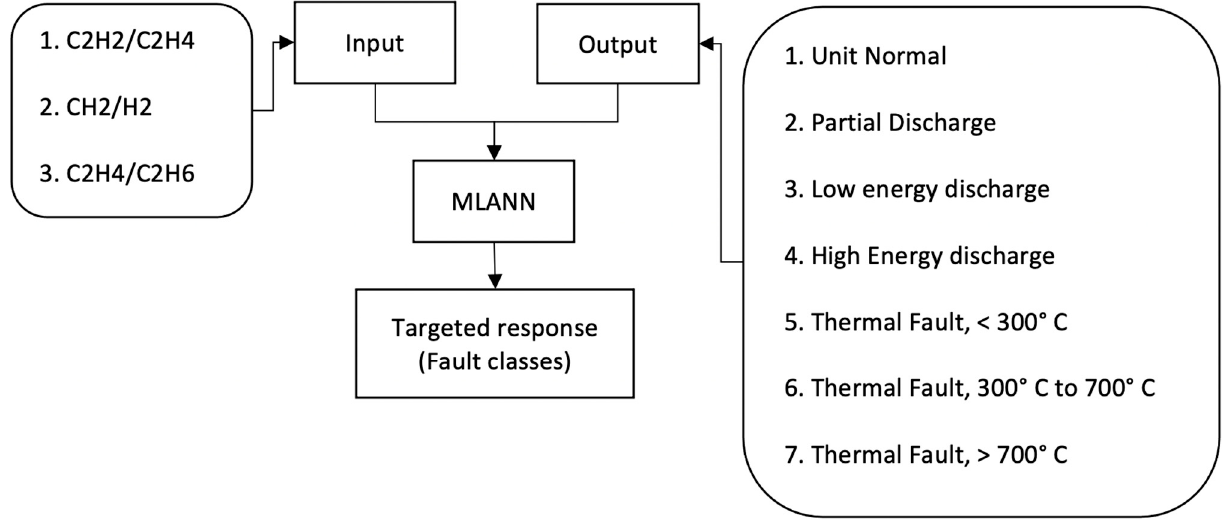
Figure 2. Function block diagram on the proposed MLANN.